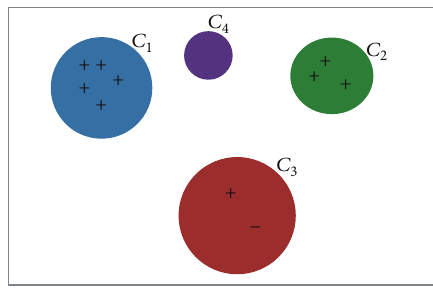
Figure 2: A demo of voting. The probability that recommended movies are in 𝐶 1 is 5/8